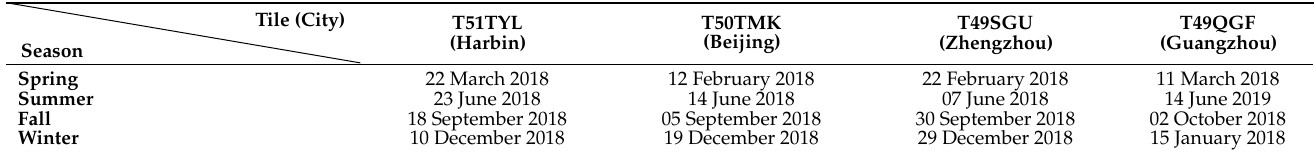
Table 1. List of dates and locations of Sentinel-2 images used in the experiment.